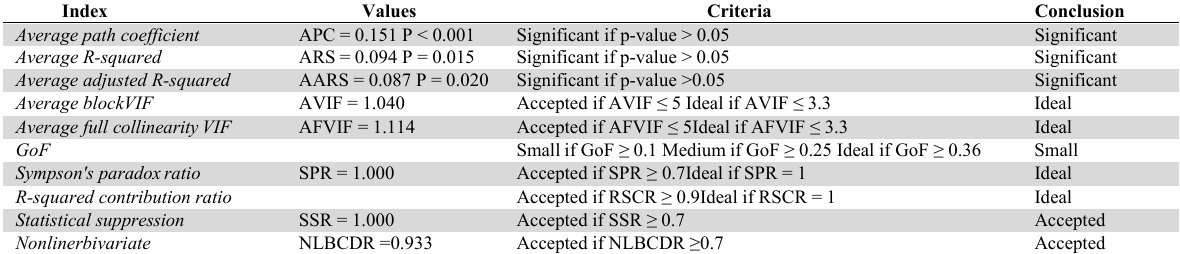
Results of the Research Model Suitability